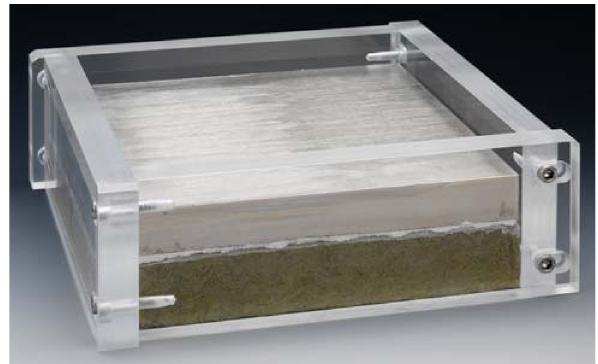
Figure 13. Experimental setup realizing the closed boundary condition (51), using geometrically adjustable walls of acrylic glass. Figure 14. Dynamic stiffness s